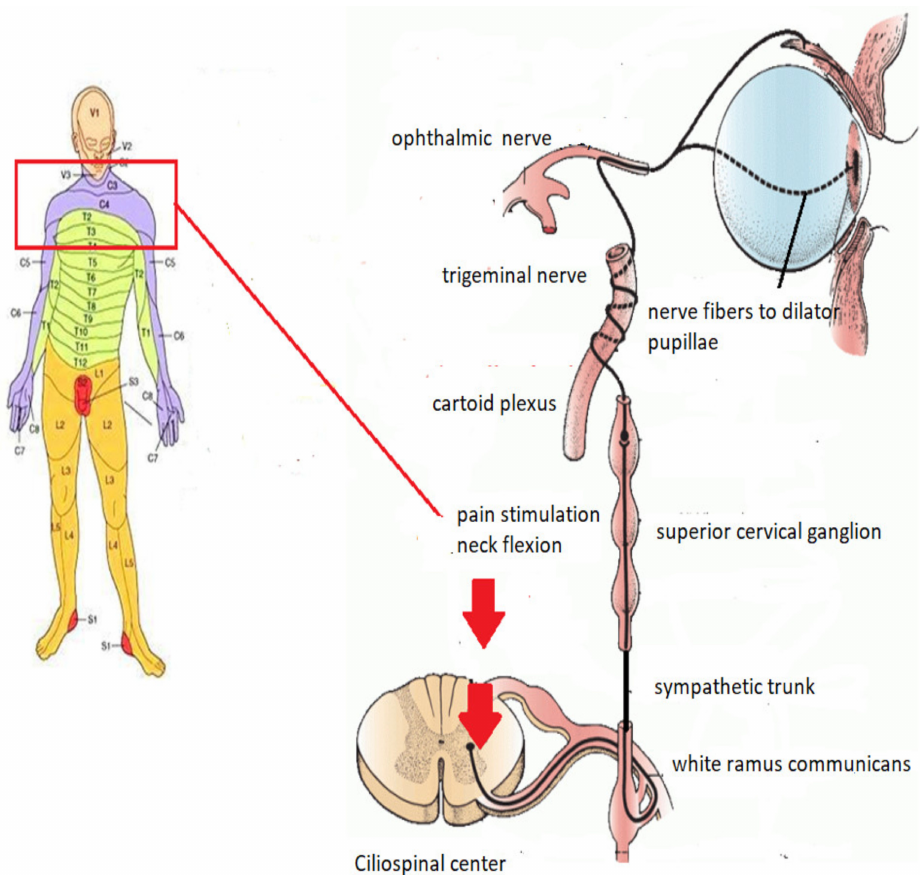
Figure 1. Ciliospinal reflex